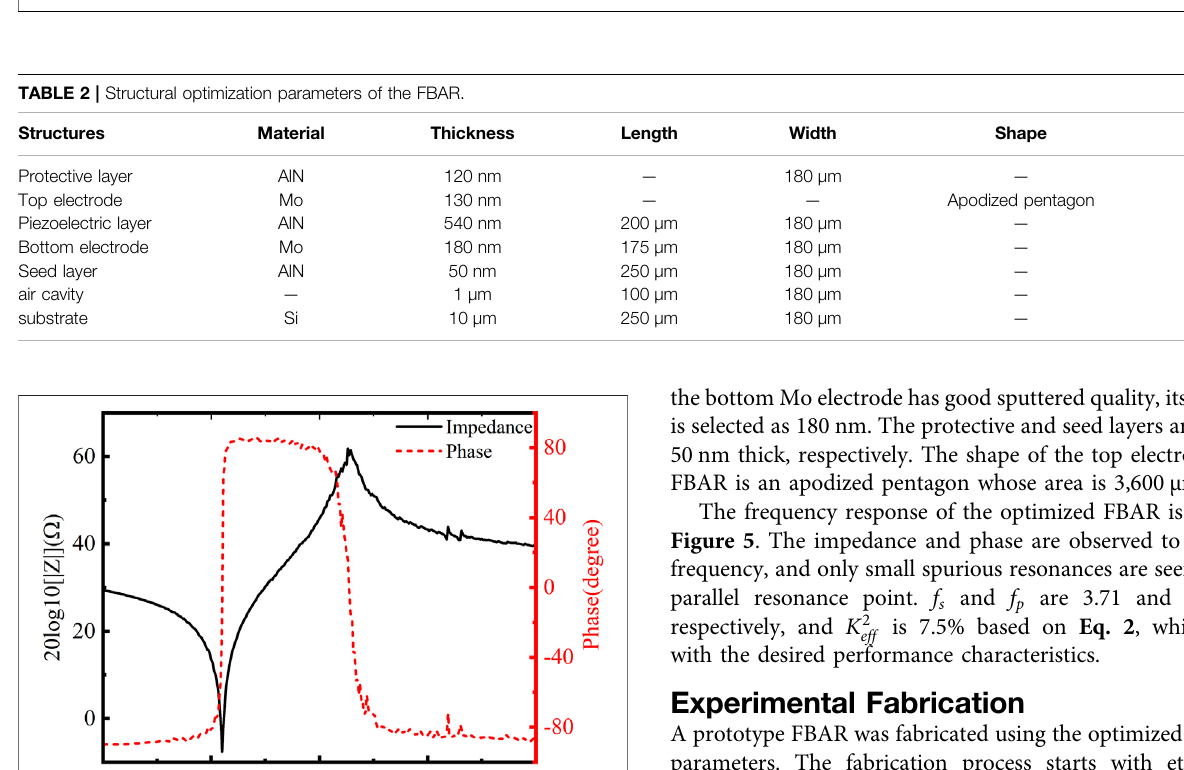
FIGURE4| SpuriousresonancesseenintheimpedanceSmithchartfordifferentshapesofthetopelectrode: (A) triangle; (B) rectangle; (C) apodizedquadrilateral; (D) circle; (E) apodized pentagon.